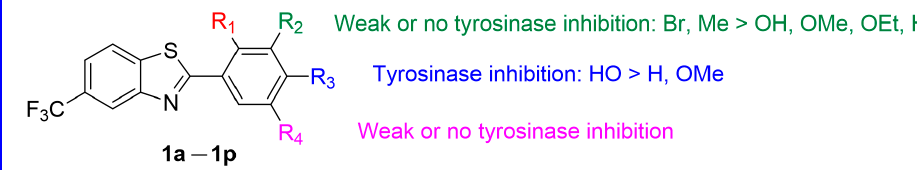
Figure 2. Structure activity relationships of 5-(trifluoromethyl)benzo[ d ]thiazole analogs 1a – 1p for tyrosinase inhibition.